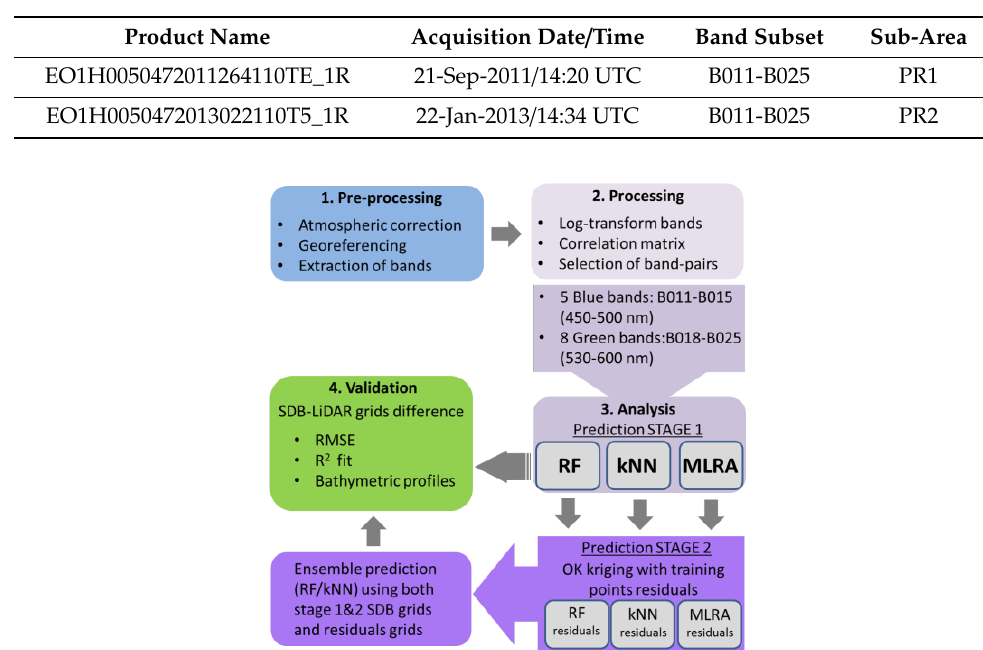
Table 1. Hyperion data details.